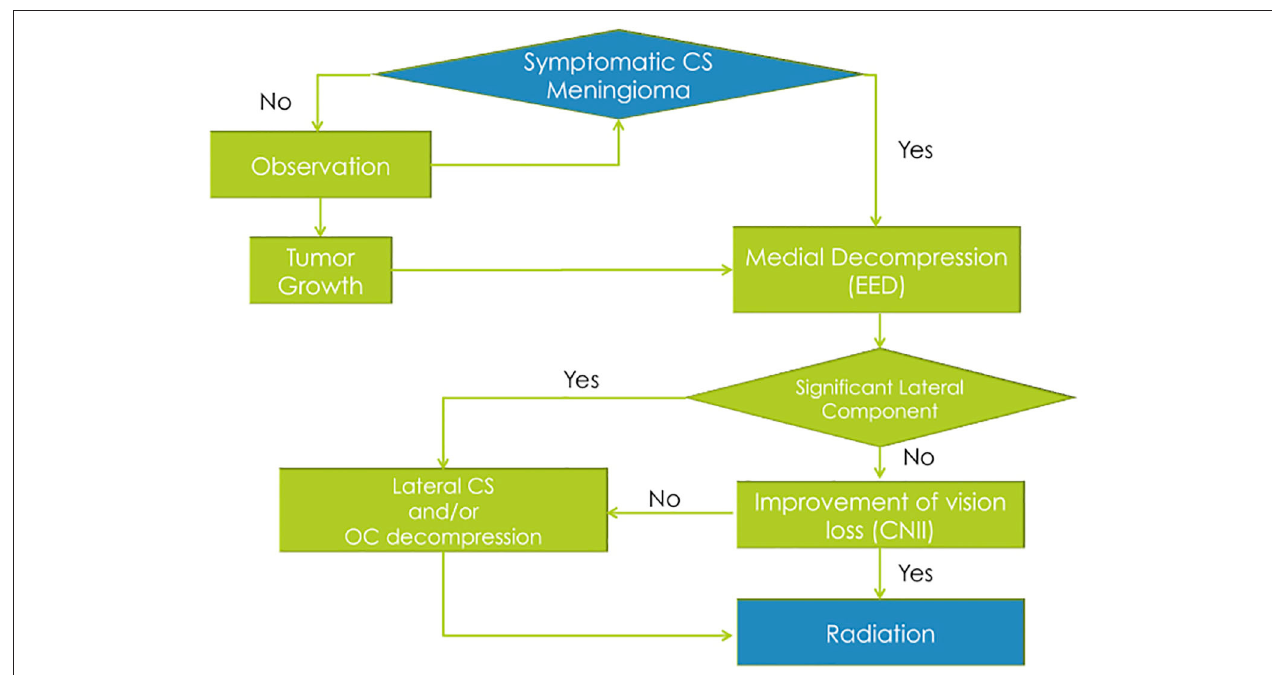
FIGURE 3 | Summary of the “functional skull base surgery” strategy used in cavernous sinus